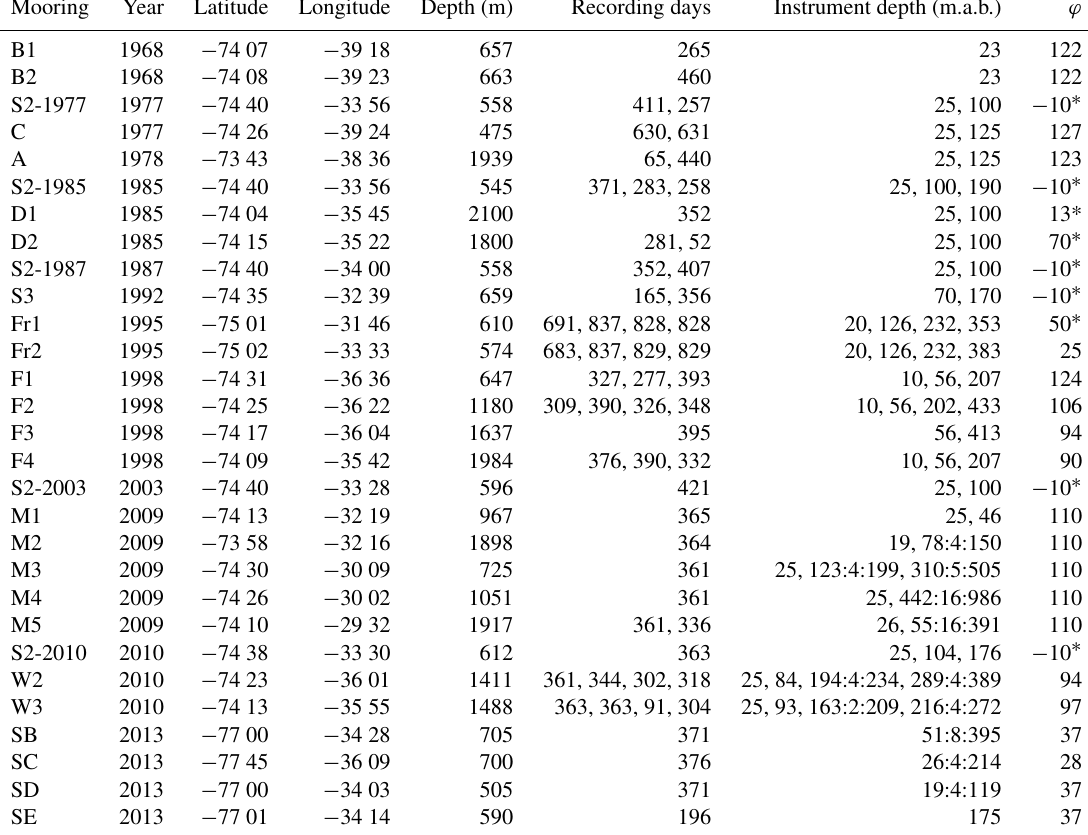
Table 1. Name, recording year, location in degrees and minutes, bottom depth, number of recording days, depths of current metres or acoustic Doppler current profilers (ADCPs) (in format “first level:depth increment:last level”) in metres above bottom (m.a.b.) and angle ϕ for the clockwise rotation of the coordinate system for all moorings used in this study. For some moorings located on the flat shelf or close to varying bathymetry (i.e. at the ridge), the rotation angles have increased uncertainty (marked with an asterisk). More details on the moorings can be found in Foldvik et al. (2004) and references therein, as well as in Jensen et al. (2013) and Darelius et al.